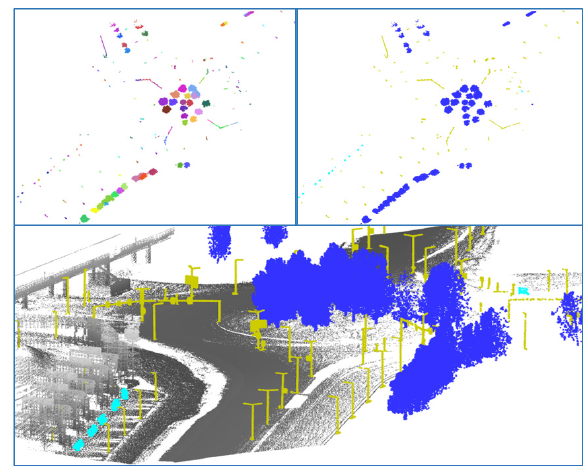
Figure 7. Seeds grown in MLS dataset 1, after phase 1 (top), and their complete segments after growing phase 2 (bottom).